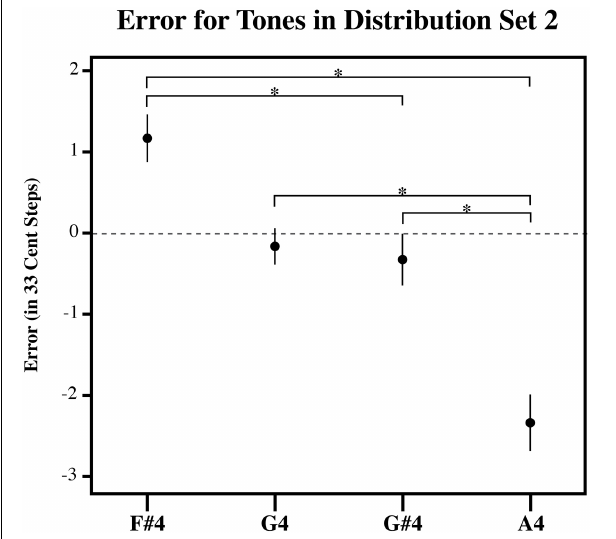
FIGURE 3 | The plot of the estimation error in 33-cent steps for each tone in Distribution Set 1. Significant pairwise comparisons (alpha 0.05) using a Sidak adjustment are indicated with an asterisk. Note that while individuals bisected the presented distribution at its midpoint, such that lower target tones in the series are overestimated and higher target tones in the series are underestimated similar to the randomly generated tone estimate data, individuals produced estimates that were significantly more accurate than the RGD ( Figure 6A ). Error bars represent ± 1 s.e.m.